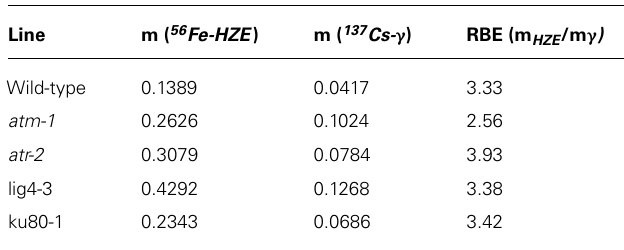
sectoring versus dose datasets forced through the